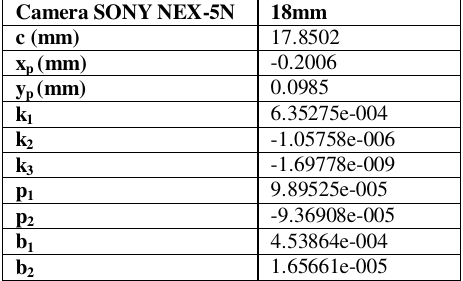
Table 3. Camera Calibration